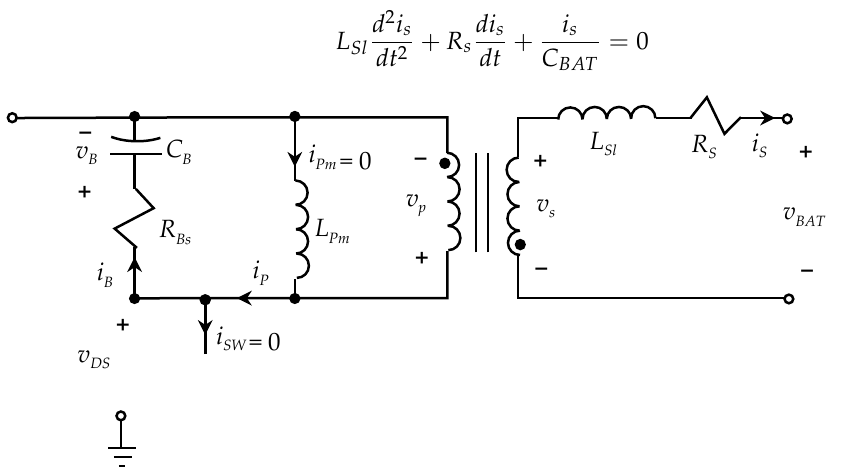
Figure 3. Equivalent circuit for the current flowing to the snubber and the battery when the secondary diode is on.